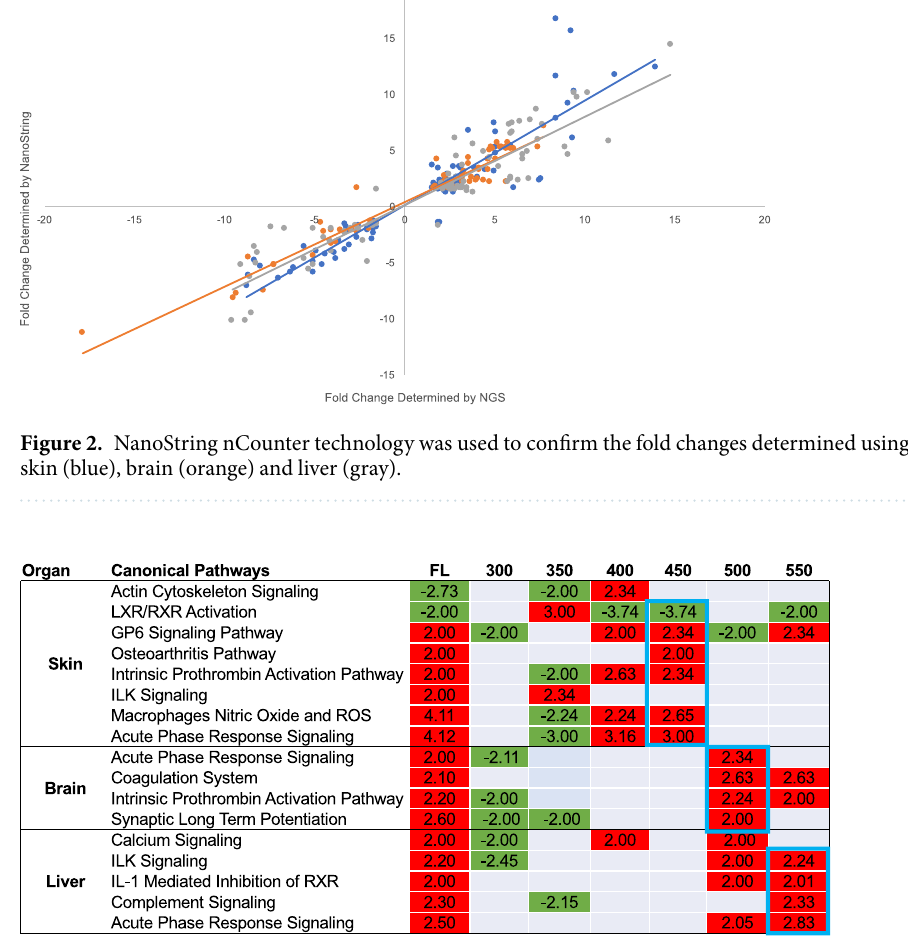
Figure 3. FL modulated pathways in zebrafish skin, brain and liver consistent with an up-regulation of the immune and inflammatory response. 50 nm regions were surveyed from 300–600 nm to determine which specific wavelengths were responsible for this response. Red indicates specific canonical pathways as determined by IPA that had a z-score of > 2 and green represent pathways with a z-score < 2. The numbers inside of each box represent the IPA determined z-score of modulation. Both 400–450 and 450–500 nm reflected the FL response in skin; 500–550 nm in brain and 550–600 nm in liver. The primary waveband mimicking the FL response is highlighted in blue for each organ. To see the number of genes represented in each pathway see Fig.